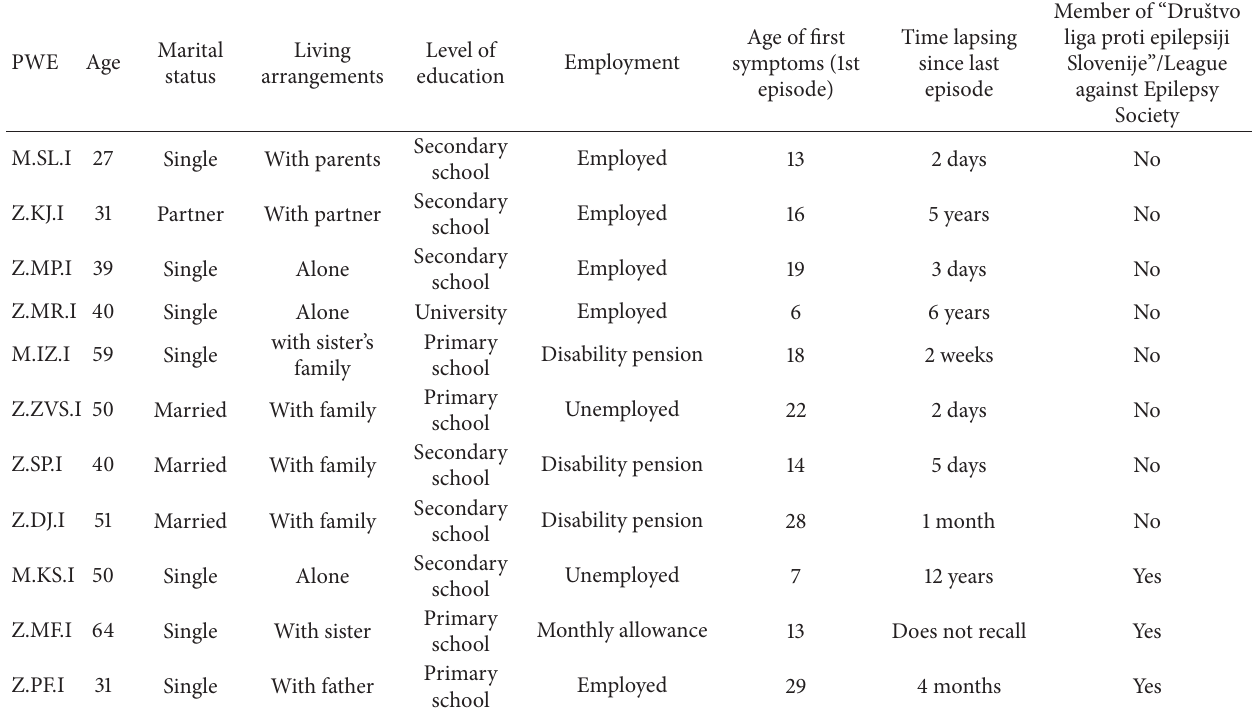
Table 1: PWE sociodemographic